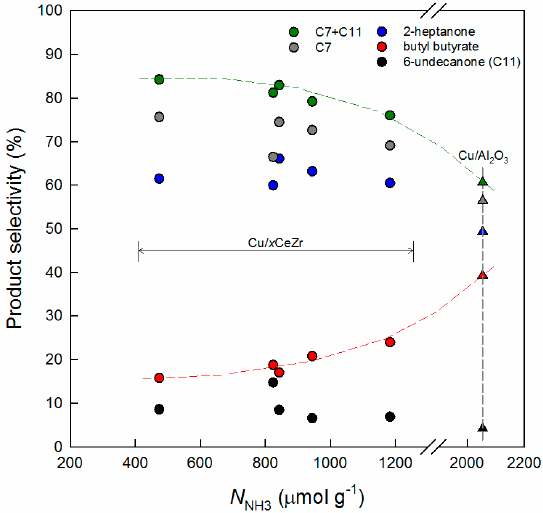
Figure 6. Product selectivities plotted against the acid site density ( N NH3 ) of Cu/ x CeZr (circles) and Cu/Al 2 O 3 (triangles) catalysts. C7 includes 3-hepten-2-one, 2-heptanone, and 2-heptanol.